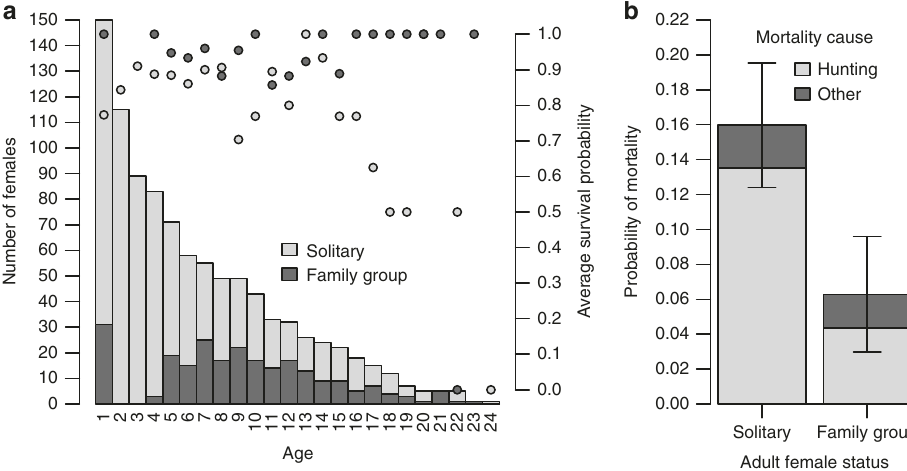
Fig. 2 Protective effect of hunting regulation for brown bear females. a Age-speci fi c number (bars, left axis) and average survival probability (dots, right axis) of female brown bears according to their status (solitary: light gray; member of a family group: dark gray) in south-central Sweden from 1993 to 2015. All cubs-of-the-year (age = 0) are dependent upon their mother and are protected from hunting by regulation, however, they are not represented in this fi gure, because their sex could not be determined. b Adult female probability of mortality (average and 95% CI) from hunting and other causes according to their reproductive status (solitary, n = 407; member of a family group, n =